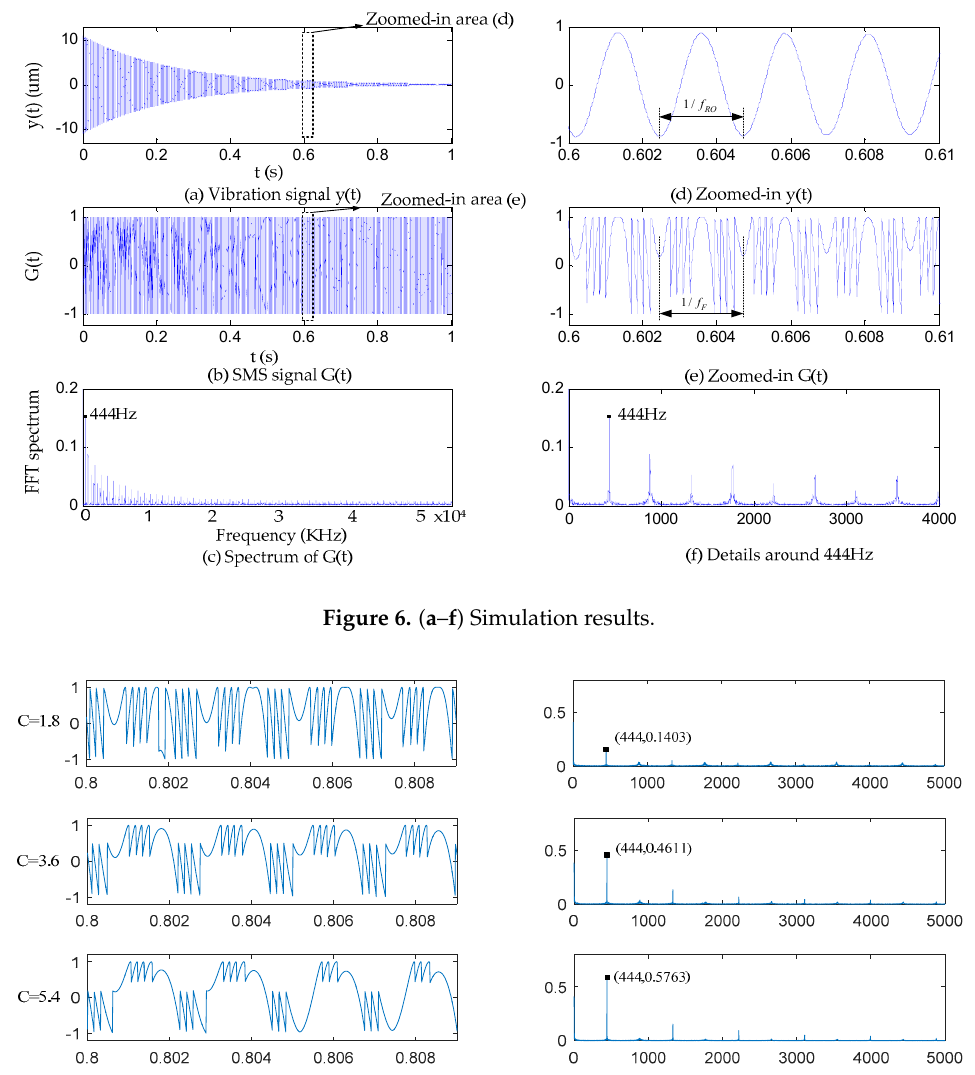
Figure 6. ( a – f ) Simulation results.